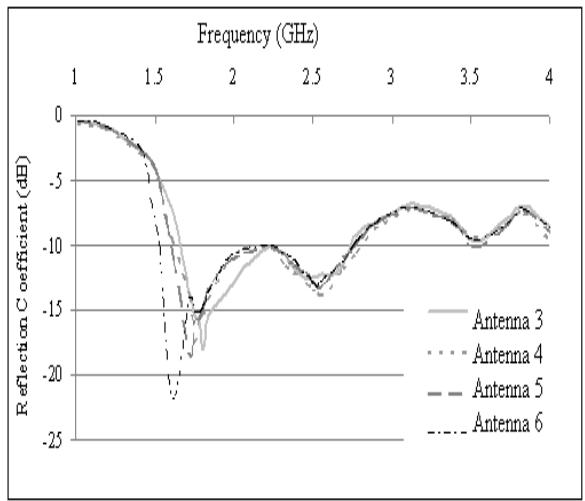
Figure 6. Measured reflection coefficients of the fractal slot antennas of three iterations.